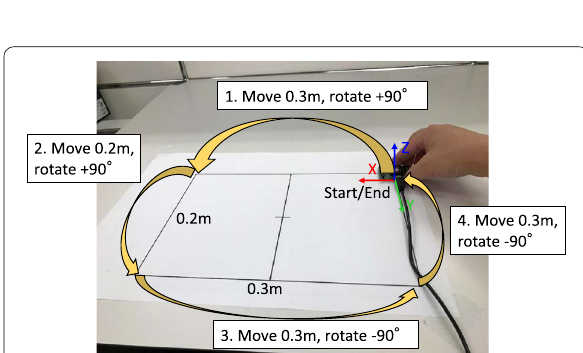
Fig. 6 IMU data collection procedure of trajectory estimation experi- ment